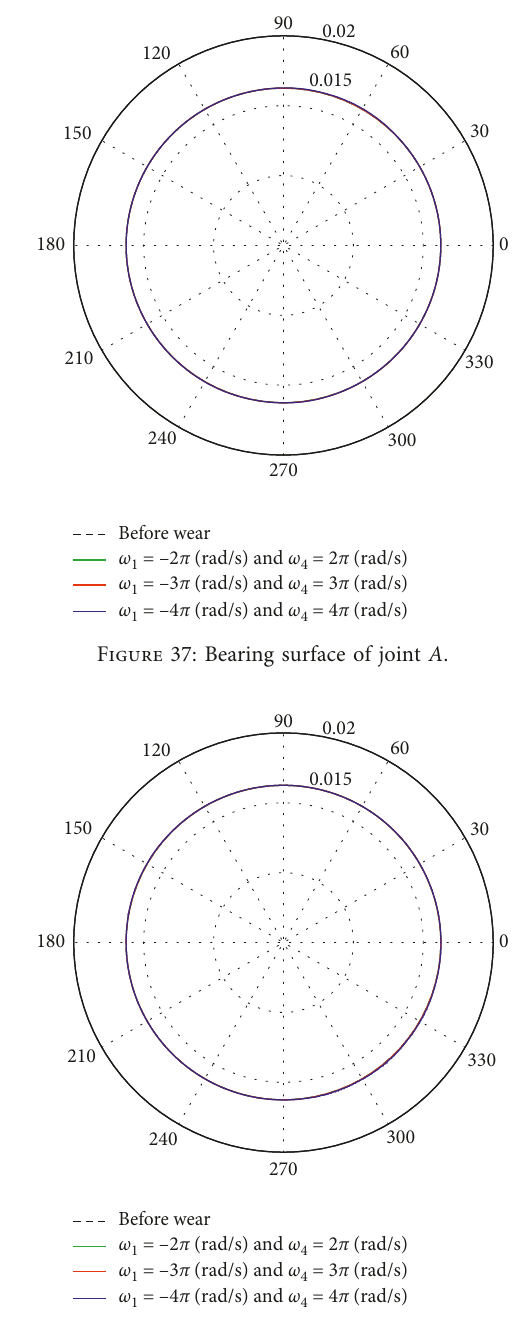
Figure 38: Bearing surface of joint B